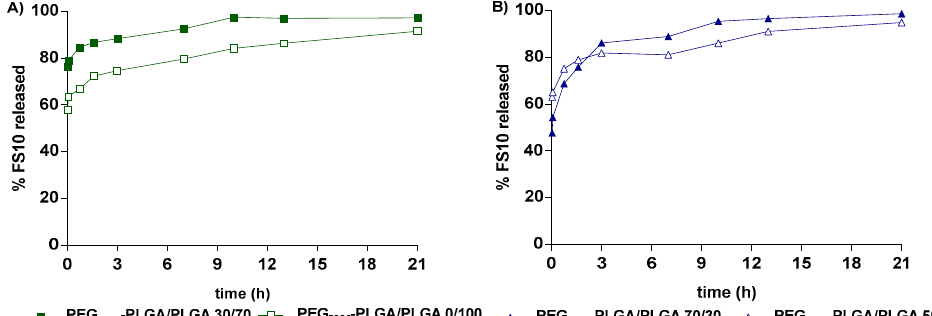
Figure 6. Release of FS10 peptide from different PLGA nanoparticles prepared by double emulsion ( A ) and nanoprecipitation ( B ) methods.